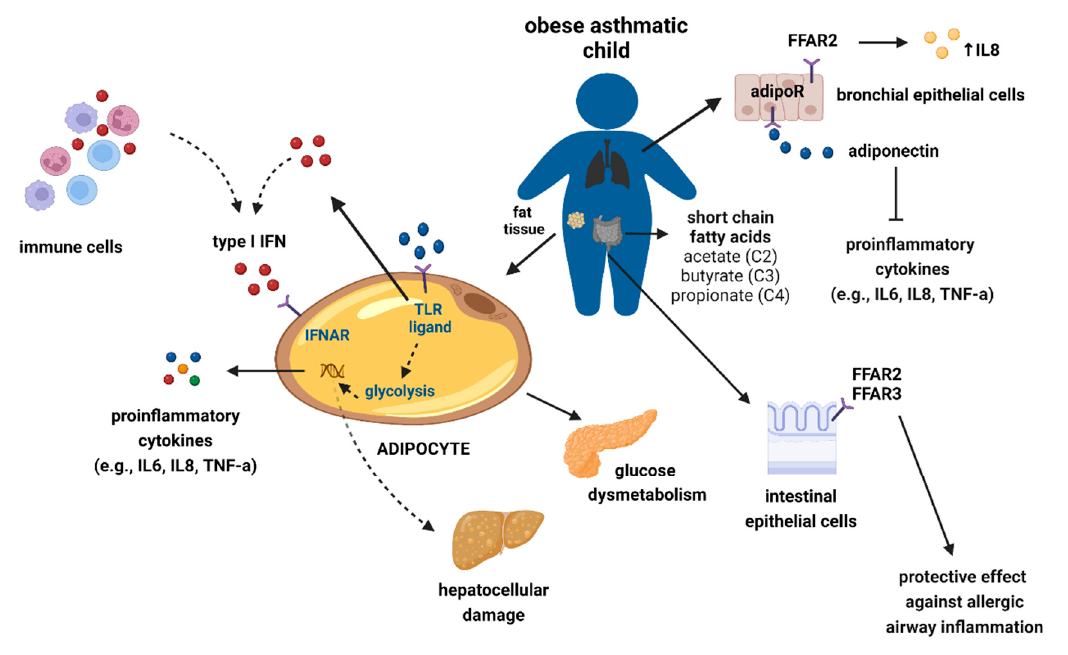
Figure 1. A representation of a model of the role of type I IFN/IFNAR axis in mediating adipocyte inflammatory processes underlying persistent airway inflammation in obese children. In fat tis- sue, adipocyte-specific IFNAR expression modifies the severity of obesity-associated glucose dys- metabolism with an impact on hepatocellular damage. More specifically, persistent type I IFN sensing may trigger T cells to become dysfunctional. The latter may explain why T cells show reduced prolif- eration and cytokines (e.g., IFN) release. In regard to inflammatory pathway mediation, adiponectin binds to adiponectin receptor AdipoR1 and reduces the activation of inflammatory pathways. FFAR2, a free fatty acid receptor, is expressed in bronchial epithelial cells and triggers the secretion of proin- flammatory cytokines, more specifically IL8. Excessive production of proinflammatory cytokines and reduced secretion of IFNs may underlie the development of chronic airway inflammatory re- sponses and explain observed associations between reduced short fatty acid secretion and asthma development in children. Abbreviations: FFAR2: Free fatty acid receptor 2, IFN: Interferon,